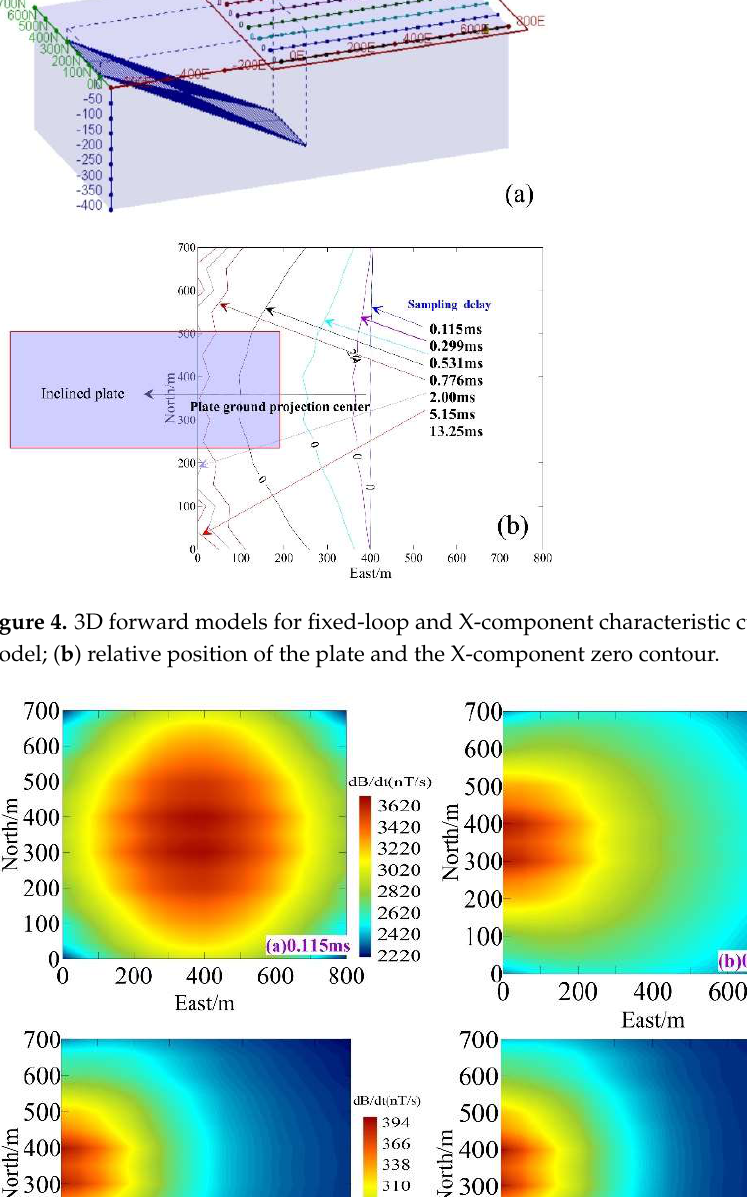
Figure 5. Three-component feature synthesis maps with different sampling times: ( a ) 0.115 ms; ( b ) 0.531 ms; ( c ) 0.776 ms; ( d ) 5.15 ms.